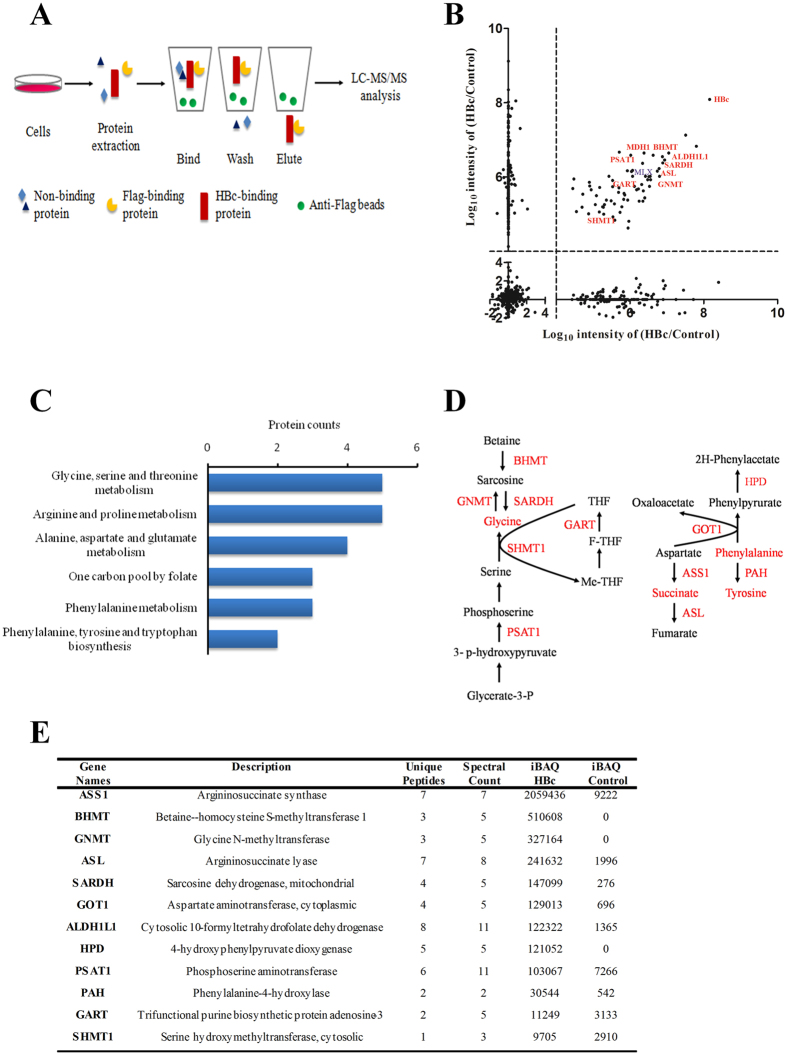
Identification of the interacting proteins of HBc.(A) A schematic diagram of the CoIP experiment for enriching the HBc interacting proteins. (B) The distribution of potential HBc interacting proteins is shown in the scatter plot with a cut-off transformed log10 intensity > 4. The highlighted dots represent some potential candidates in this study. (C) The KEGG annotation revealed the pathways regulated by HBc. (D) Graphical demonstration of the predominant enzymes that bind HBc and their involvement in the metabolic pathways. (E) MS information of the HBc interacting proteins.